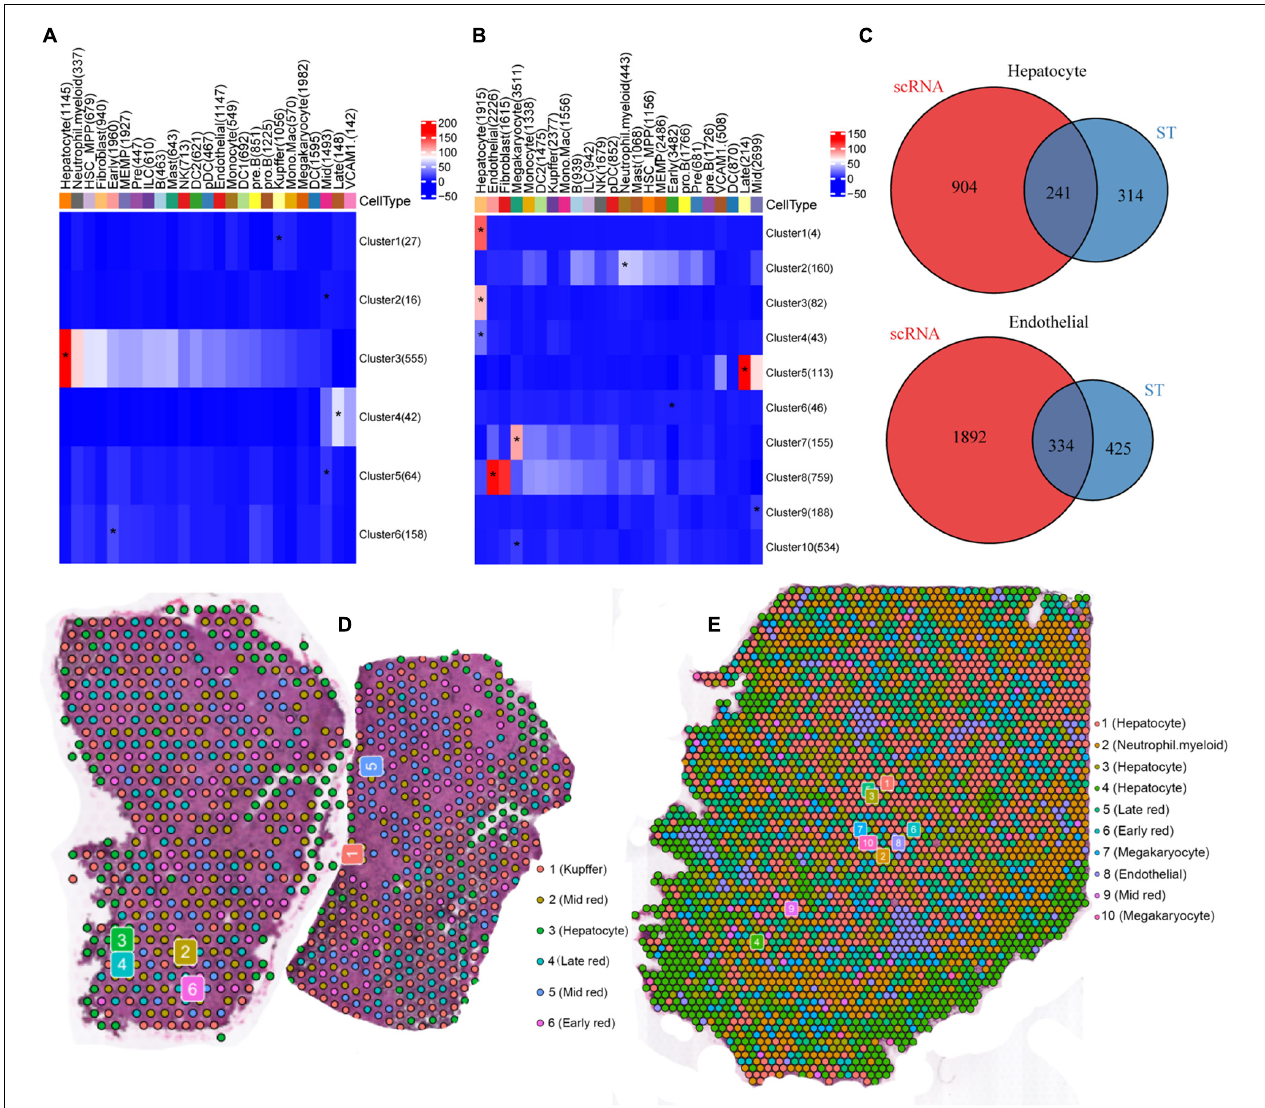
FIGURE 2 | Spatially resolved gene expression of embryonic livers. (A,B) The MIA map of all scRNA-seq-identified cell types and ST-defined regions in 8 PCW (A) and 17 PCW liver (B) . The numbers of cell type- and tissue region-specific genes used in the calculation are shown. Red indicates enrichment (significantly high overlap); blue indicates depletion (significantly low overlap). (C) Venn diagram showing the overlaps of specifically expressed genes of hepatocyte and Endothelial cells between ST and scRNA-seq data. (D,E) The spots visualized at their original positions in the 8 PCW live tissue (D) , and the 17 PCW live tissue (E) . The colors indicate the clusters each spot is assigned to in the t-SNE plot in Figures 1A,B .